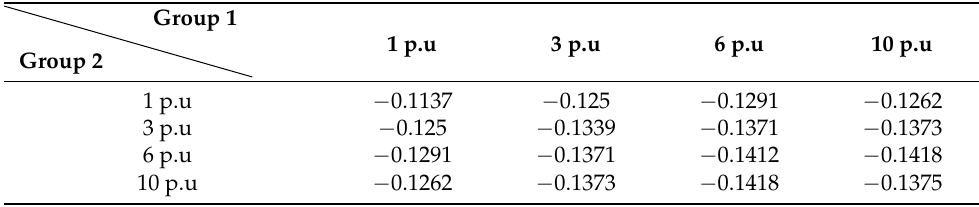
Table 1. Damping coefficient for TM1 of SG under different K p .